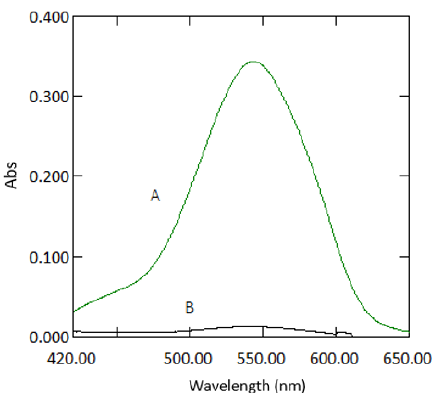
Figure 11. Absorption spectra of coloured species (1 mg · L − 1 chromium) versus reagent blank ( A ) and reagent blank versus double deionised water ( B ).